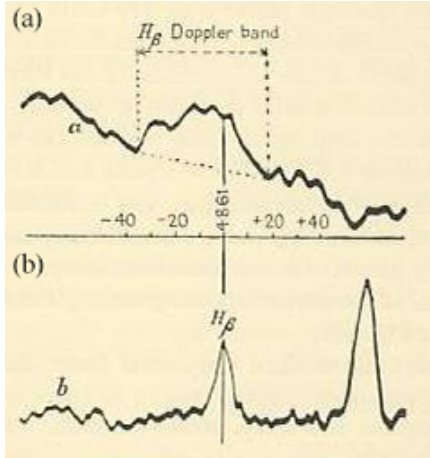
Figure 3. Example of H β line Doppler-shifted towards the violet (a) in comparison with the unshifted line (b) observed in Vegard’s